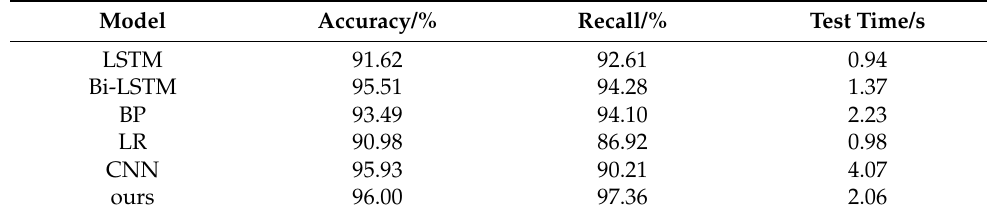
Table 4. Comparison of Testing Effects of Different